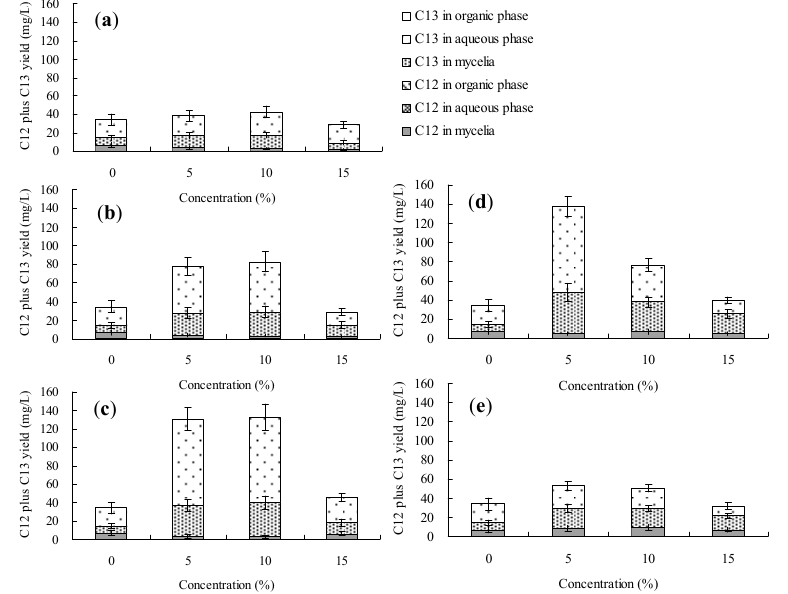
Figure 8. Effects of 1-hexadecene on palmarumycin production in liquid culture of Berkleasmium sp. Dzf12. 1-Hexadecene was applied at 0%, 5%, 10% and 15% on days 0 ( a ); 3 ( b ); 6 ( c ); 9 ( d ) and 12 ( e ) of culture, respectively. The period of culture lasted for 15 days. “C12” means palmarumycin C 12 , “C13” means palmarumycin C 13 . The error bars represent standard deviations from three independent samples.